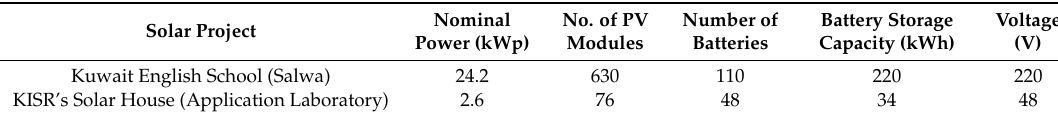
Figure 4. Solar projects in Kuwait: ( a ) Sawda bin Zamaa PV rooftop grid connected; ( b ) Al-Zahra Co-op Parking Shades PV Rooftop-Grid connected; ( c ) Al-Zahra Petrol Station PV Rooftop-Grid connected; ( d ) Azda bint alhareth School PV Rooftop-Grid connected. Adapted from [30]. Table 2. Current solar projects in Kuwait. Adapted from [30].